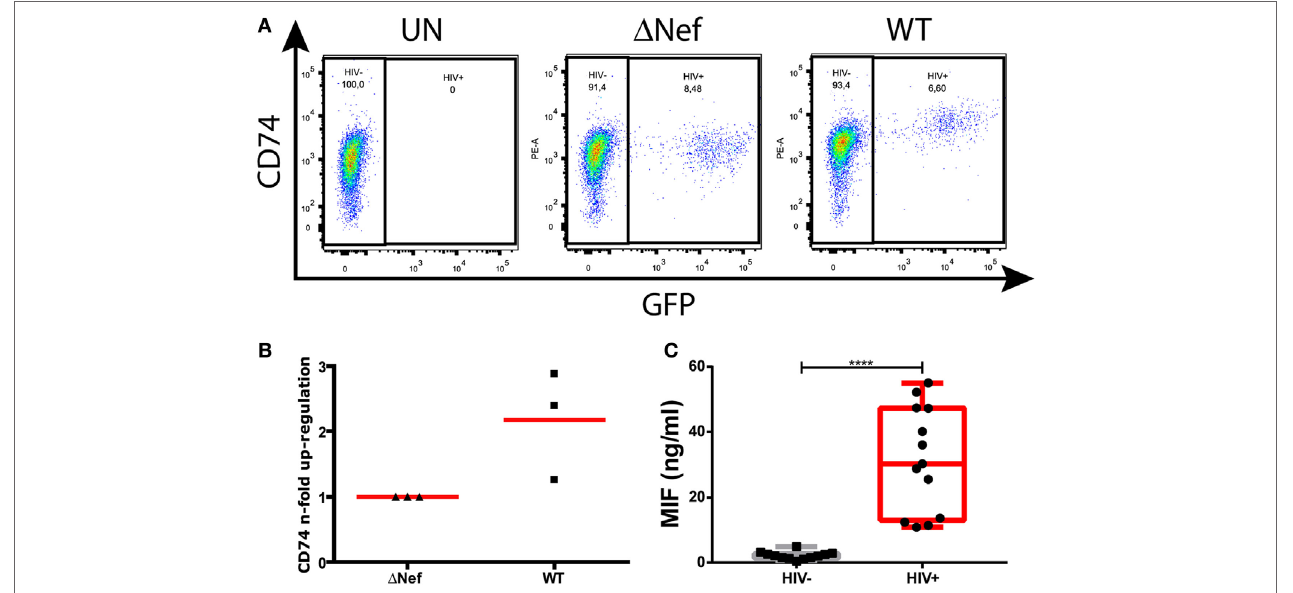
FigUre 1 | CD74 upregulation in human immunodeficiency virus (HIV)-infected monocyte-derived macrophages (MDMs) and macrophage migration inhibitory factor (MIF) plasma levels in HIV + subjects. (a) Flow cytometry analysis of CD74 surface expression in primary uninfected MDMs (left panel); infected MDMs with a Nef-defective virus expressing the reporter molecule GFP ( Δ Nef HIV-1, middle panel); and infected with a wild type (WT) HIV-1 also expressing the reporter molecule GFP (WT HIV, right panel). The plots show CD74 versus GFP expression (HIV-1 infection) on MDMs [gated previously in a forward scatter (FSC) versus side scatter plot]. In each dot plot, two different populations were gated: the HIV-1 negative population (GFP negative) and the HIV-1 positive population (GFP positive). One representative healthy donor, out of three donors, is shown. (B) Quantitation of Nef-mediated upregulation of CD74, calculated as the ratio between FL-2 MFI obtained for cells infected with the WT virus and the FL-2 MFI obtained for cells infected with the Δ Nef virus. Each black dot represents one out of three independent experiments (donors). Horizontal red bars stand for the mean value. (c) MIF concentration in plasma obtained from HIV-negative (HIV − , N = 13) and HIV-positive (HIV + , N = 13) donors. Each plasma was evaluated in duplicate. Dots represent the average of duplicates for each donor. Data were normally distributed and analyzed by two-tailed unpaired Student’s t -test. Horizontal lines within boxes represent the median and whiskers extend from min to max. **** p <